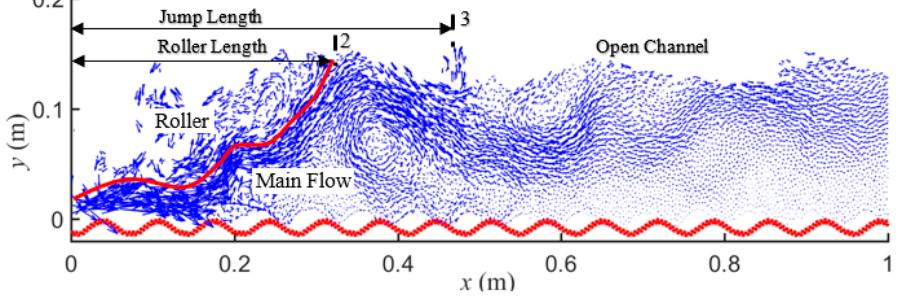
Figure 8. Definitions of roller length and jump length. Table 4. Roller lengths and jump lengths of Cases A–F.